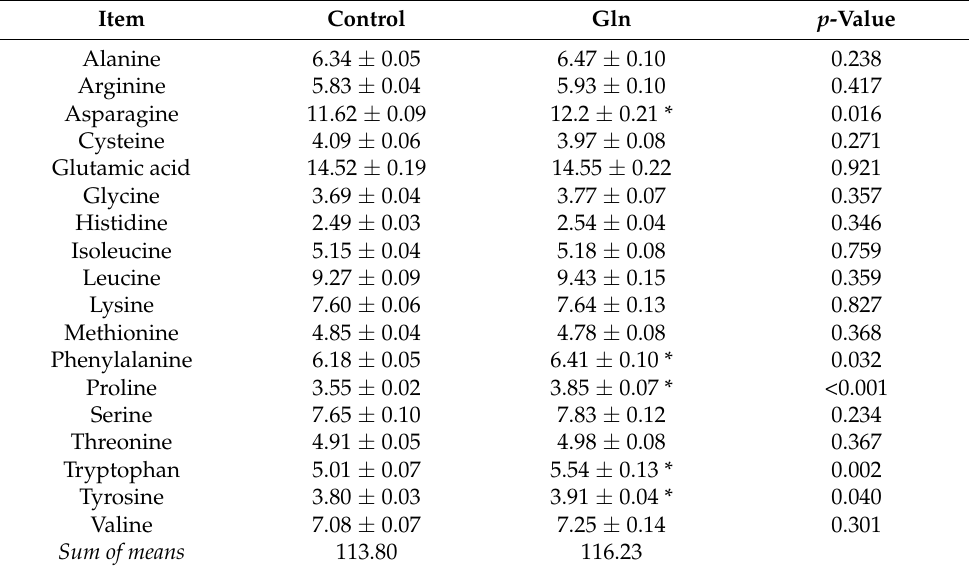
Table 4. The effect of dietary L-glutamine (Gln) supplementation (1.0%) on the albumen amino acid content (mg/g of egg albumen) of eggs from laying Bovans Brown hens at the end of a 30-week-long supplementation period (31st–60th wks of